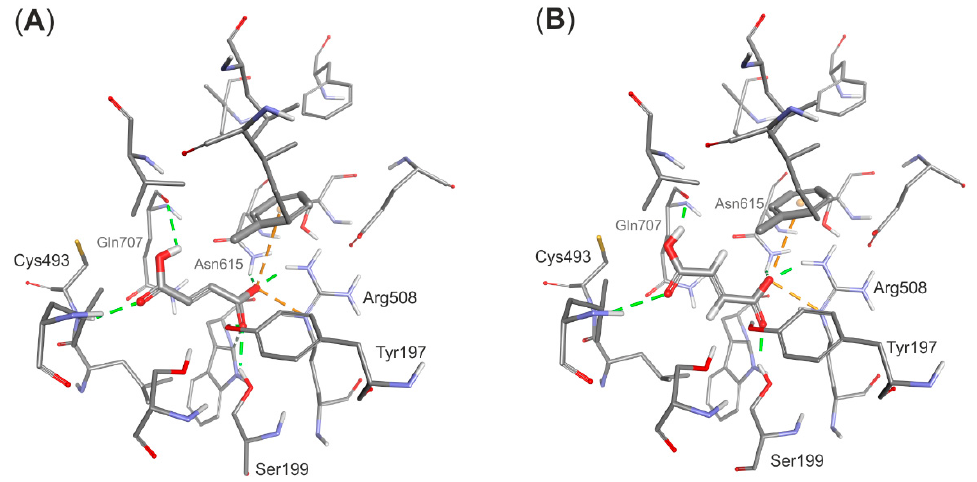
Figure 5. The structure of MM optimized enzyme-substrate complex for ( A ) pro( R )-oriented fumarate and ( B ) pro( S )-orientated fumarate. Green lines indicate H-bonds, orange lines ionic interactions. Amino acid that form H-bond interactions with fumarate were labelled.